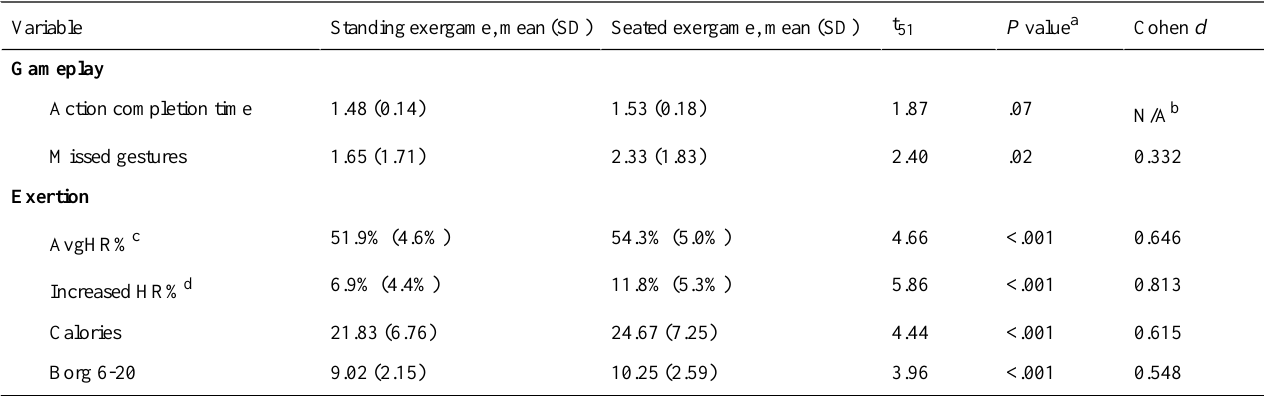
Table 3. Gameplay data and exertion